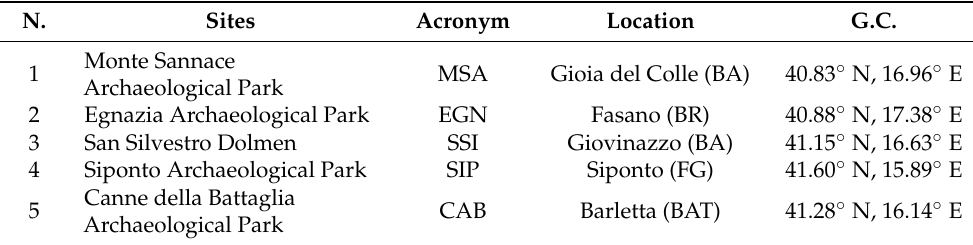
Table 1. Archaeological sites